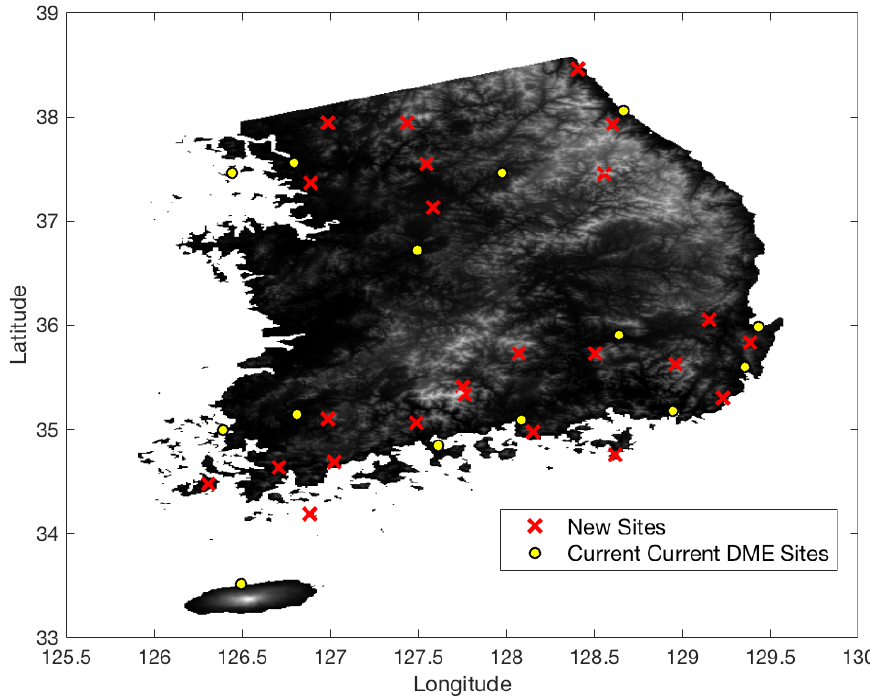
Figure 16. Augmented DME network for 0.3 nm horizontal positioning accuracy with DME/S in South Korea.